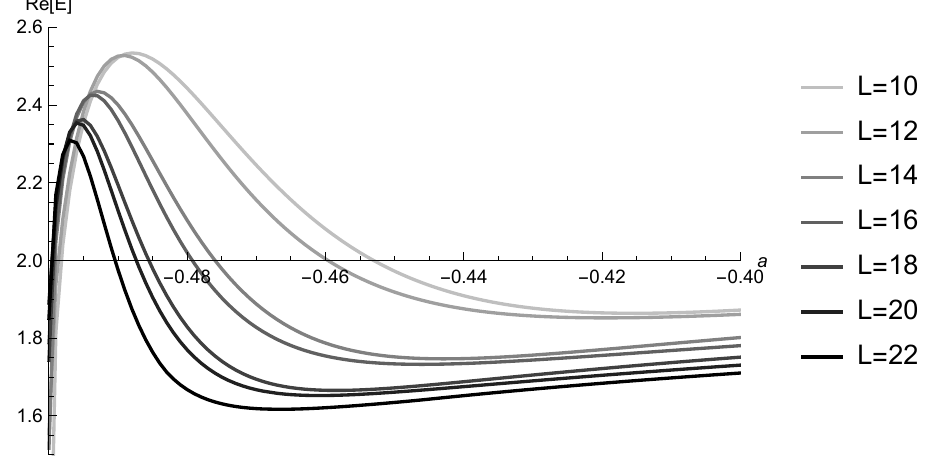
Figure 2 . Plots of the real part of the energy E (2.15) for the “double brane” solution Φ D a & − 1 / 2 at the truncation level L = 10 , 12 , · · · , 22 . The horizontal axis denotes the value of the parameter a at Re E = 2 . The vertical axis stands at a = − 1 / 2